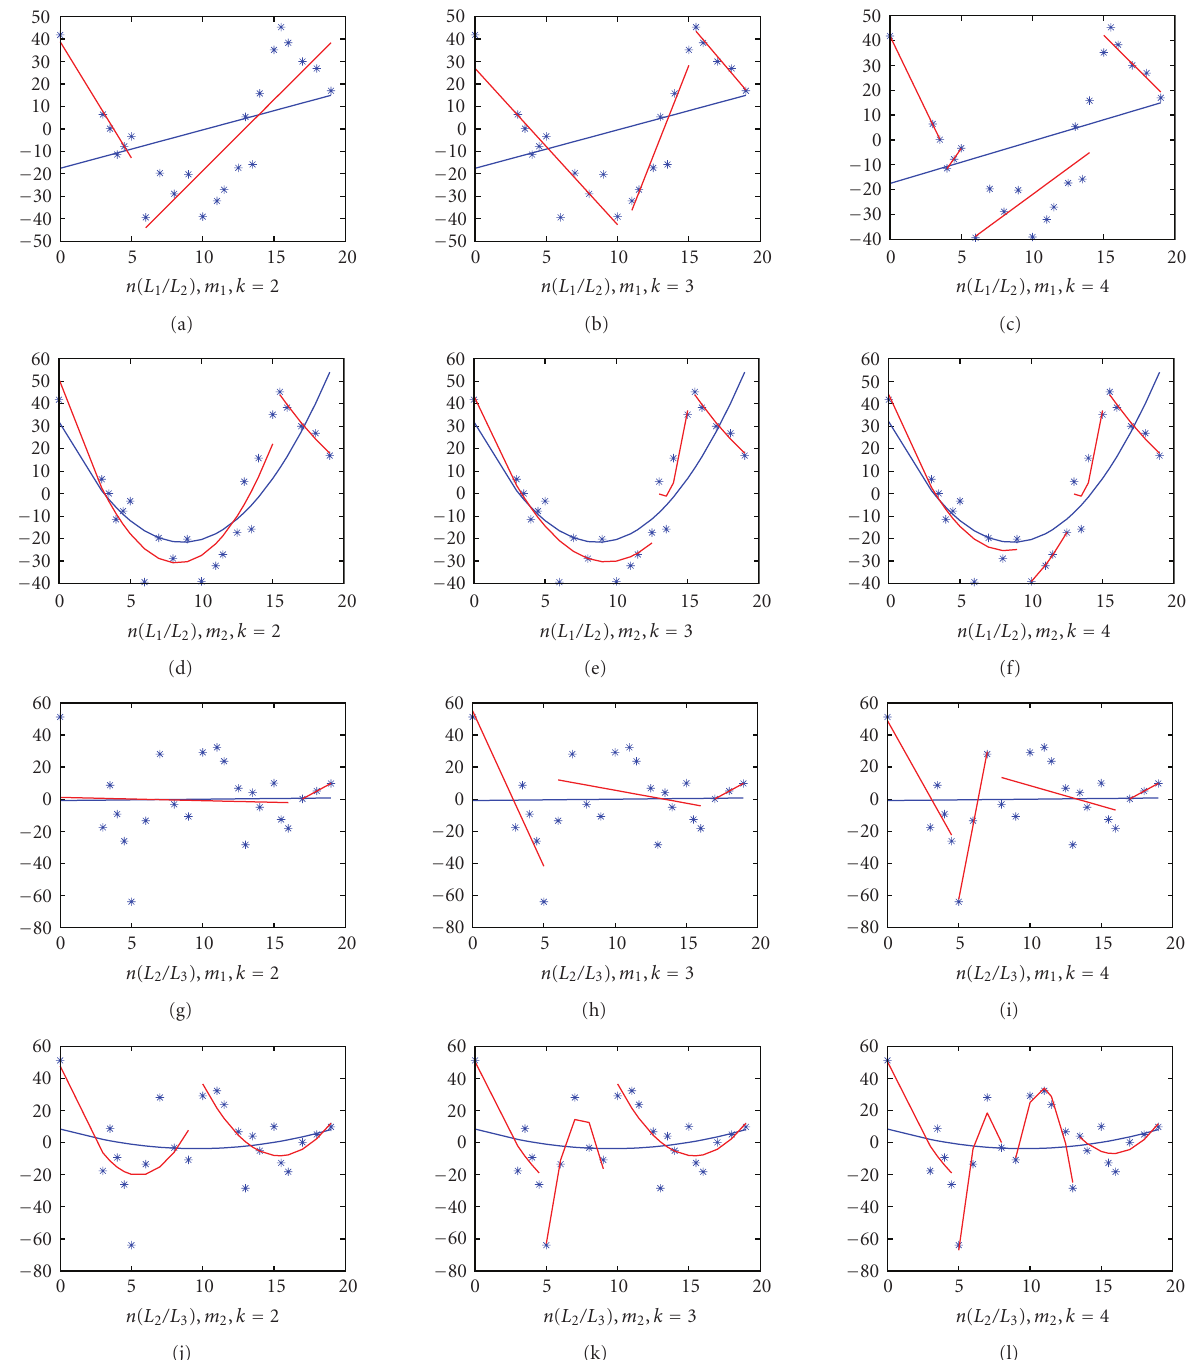
Figure 4: Illustration of the Bayesian cut fitting applied to the real data on features of the skeletal age.